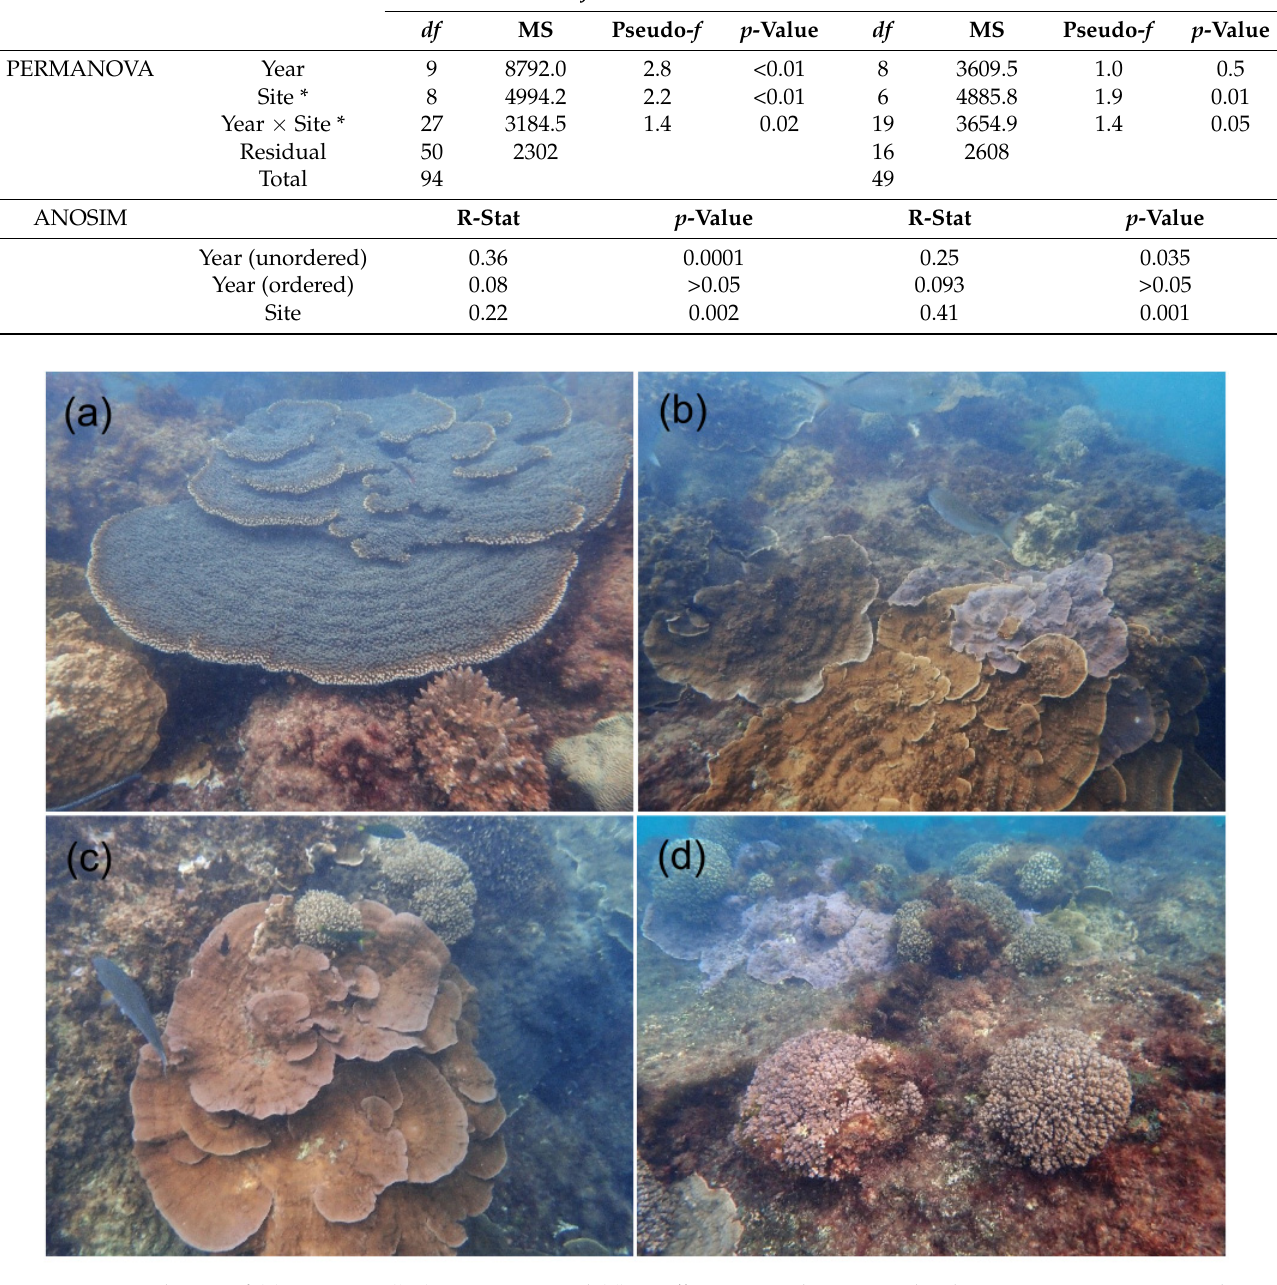
Figure 7. Colonies of ( a ) Acropora , ( b , c ) Montipora, and ( d ) Pocillopora at Fishermans Island 2, Jurien Bay Marine Park, Western Australia (photos: C. Ross, taken in May 2021).